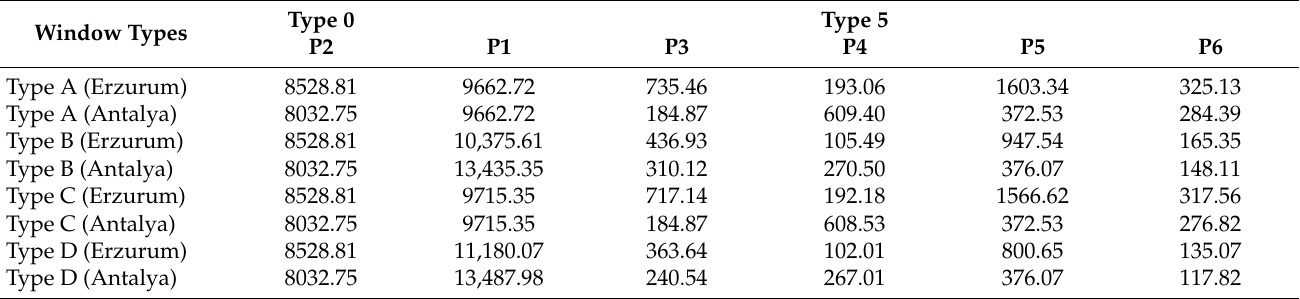
Table 12. Comparison of costs for all types